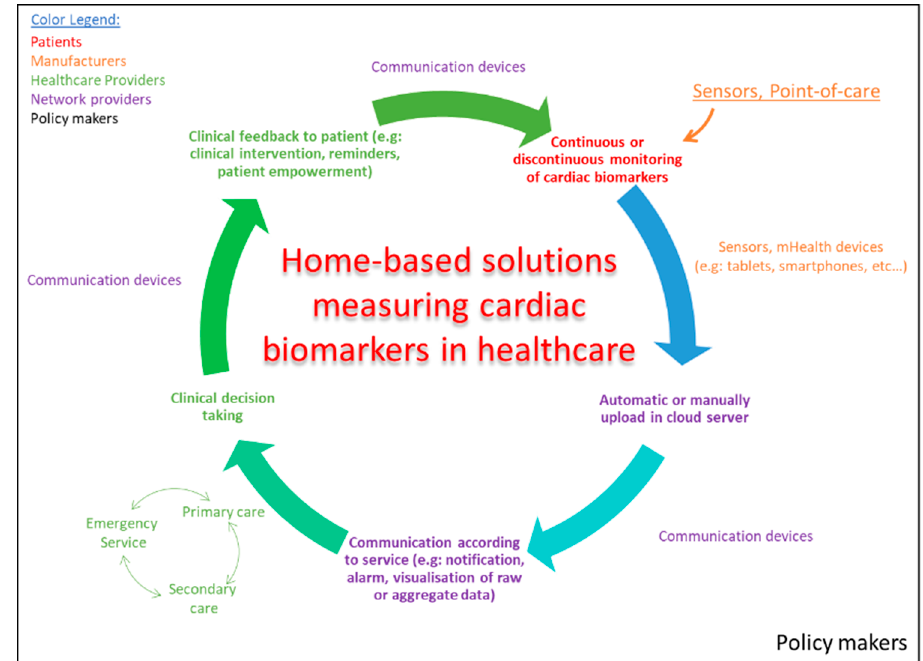
Figure 4. Schematic illustration of the different steps in home-based solutions implemented in current healthcare practices to remotely monitor patients based on cardiac biomarkers and where the different stakeholders contribute the most.